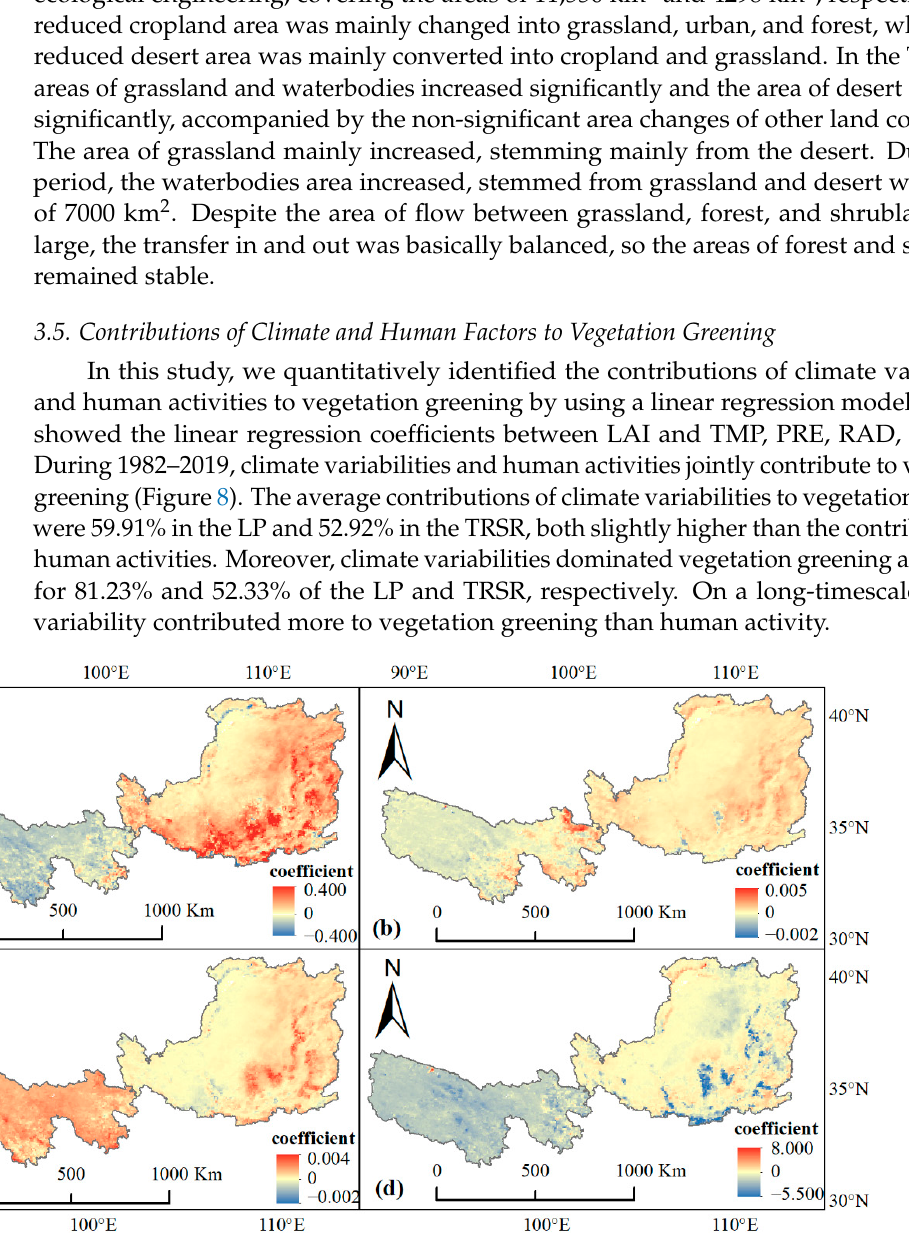
Figure 7. Spatial patterns of the linear regression coefficients between the LAI and TMP ( a ), PRE ( b ), RAD ( c ), VPD ( d ) during 1982–2019.